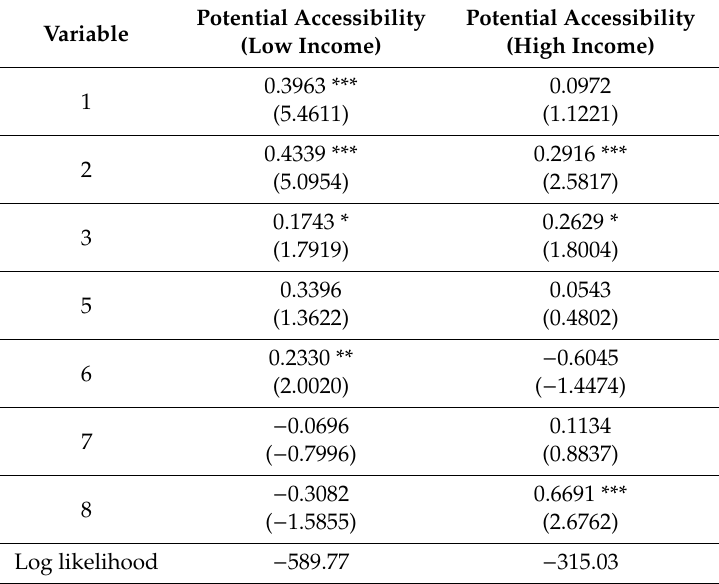
Table 4. The impact of income on potential